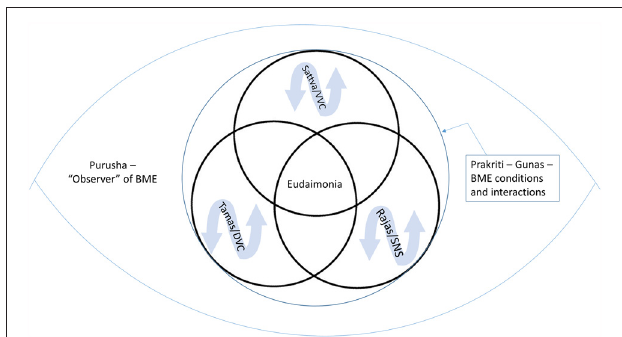
FIGURE 1 | The central eye represents the body, mind and environmental context (BME) and the peripheral eye represents the context of an observer/experiencer of that content. Within Prakriti, resilience is represented by the capacity to recognize and shift states, as well as changing the relationship to the fluctuations of the gunas (rajas/tamas/sattva) and neural platforms (sympathetic nervous system (SNS)/dorsal vagal complex (DVC)/ventral vagal complex (VVC)). Yoga aims to facilitate the emergence of qualities such as eudaimonia by strengthening the experience of sattva and VVC as well as developing facility in moving between gunas and neural platforms and changing the relationship and response to the inherent changing nature of the body, mind and environment reflected in gunas and neural